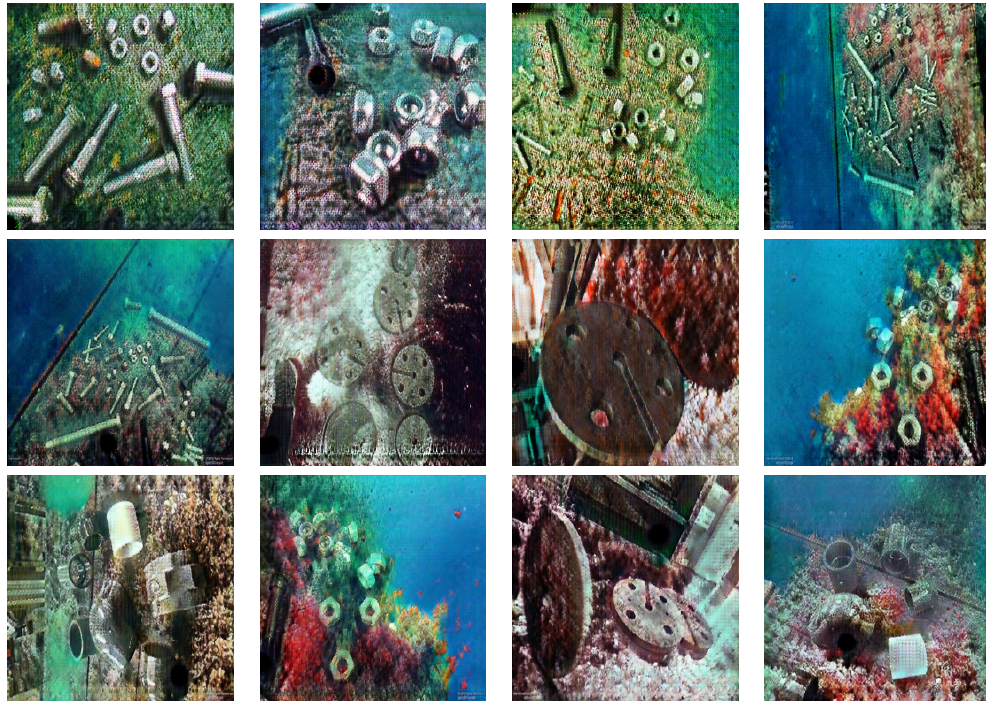
Figure 4. CycleGAN model images